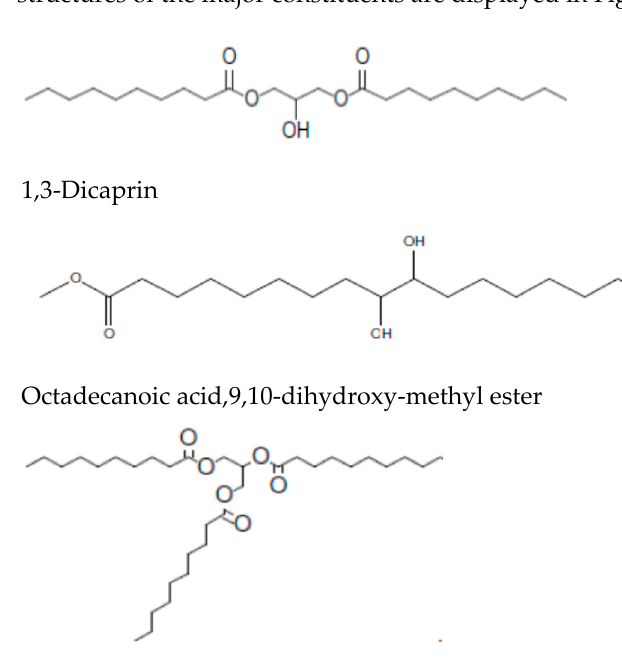
Figure 2. Major constituents found in n-butanol S. lappa root extract.